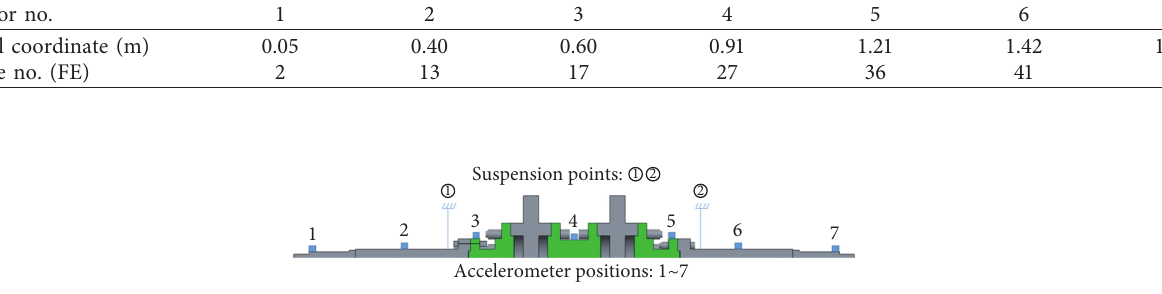
Figure 5: Modal testing of the tie-bolt rotor under free-free boundary conditions using 7 accelerometers.